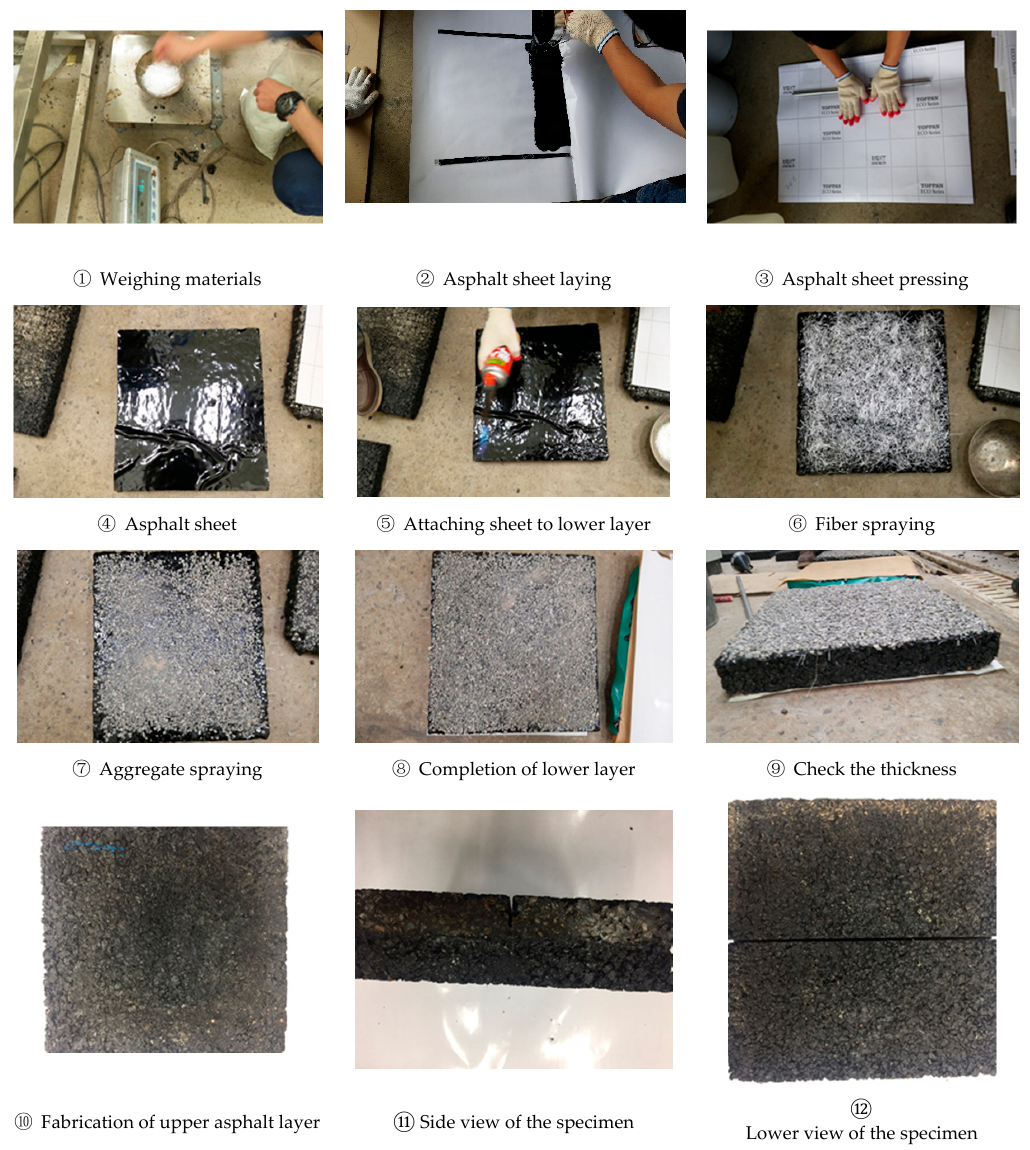
Figure 1. Fabrication of model mobile load simulator 3 (MMLS3) specimen.